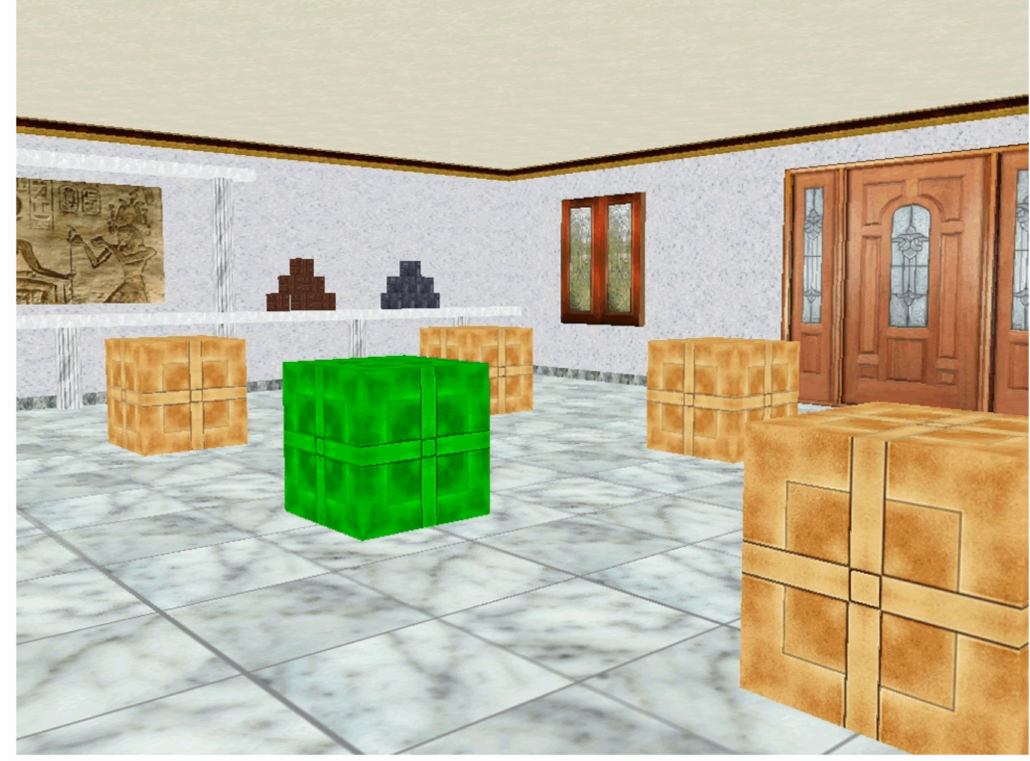
Figure 2. The Boxes Room Task. Participants explore the room using a joystick. The rewarded boxes turn green when located, whereas non rewarded boxes turn red. Unopen boxes remain brown. Several stimuli help to disambiguate spatial locations, such as a door, a window, and pictures hanging on the